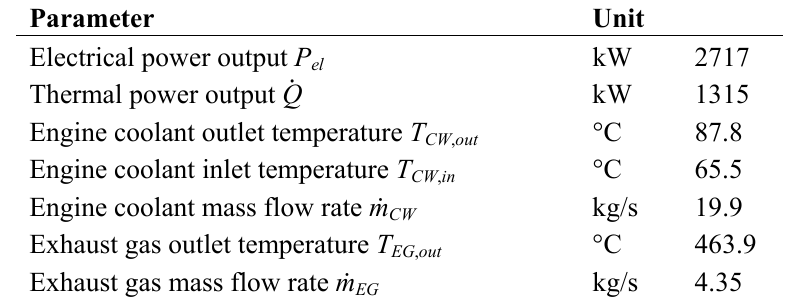
Table 2. Operational parameters of the biogas cogeneration unit (JMS 620